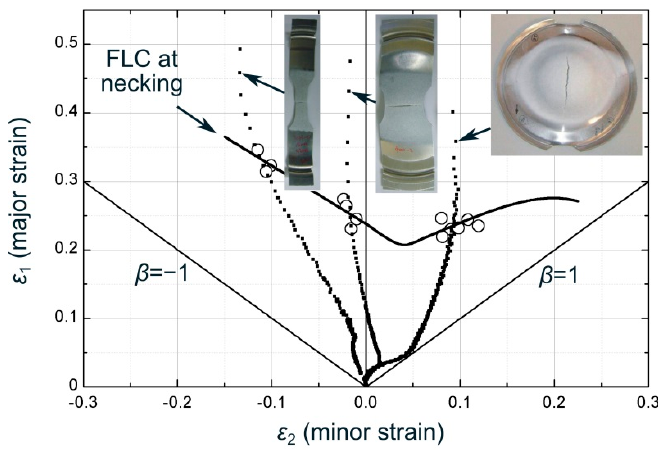
Figure 2. Forming limit curve for AA7075-O sheets of 1.6 mm thickness and strain paths from DIC.